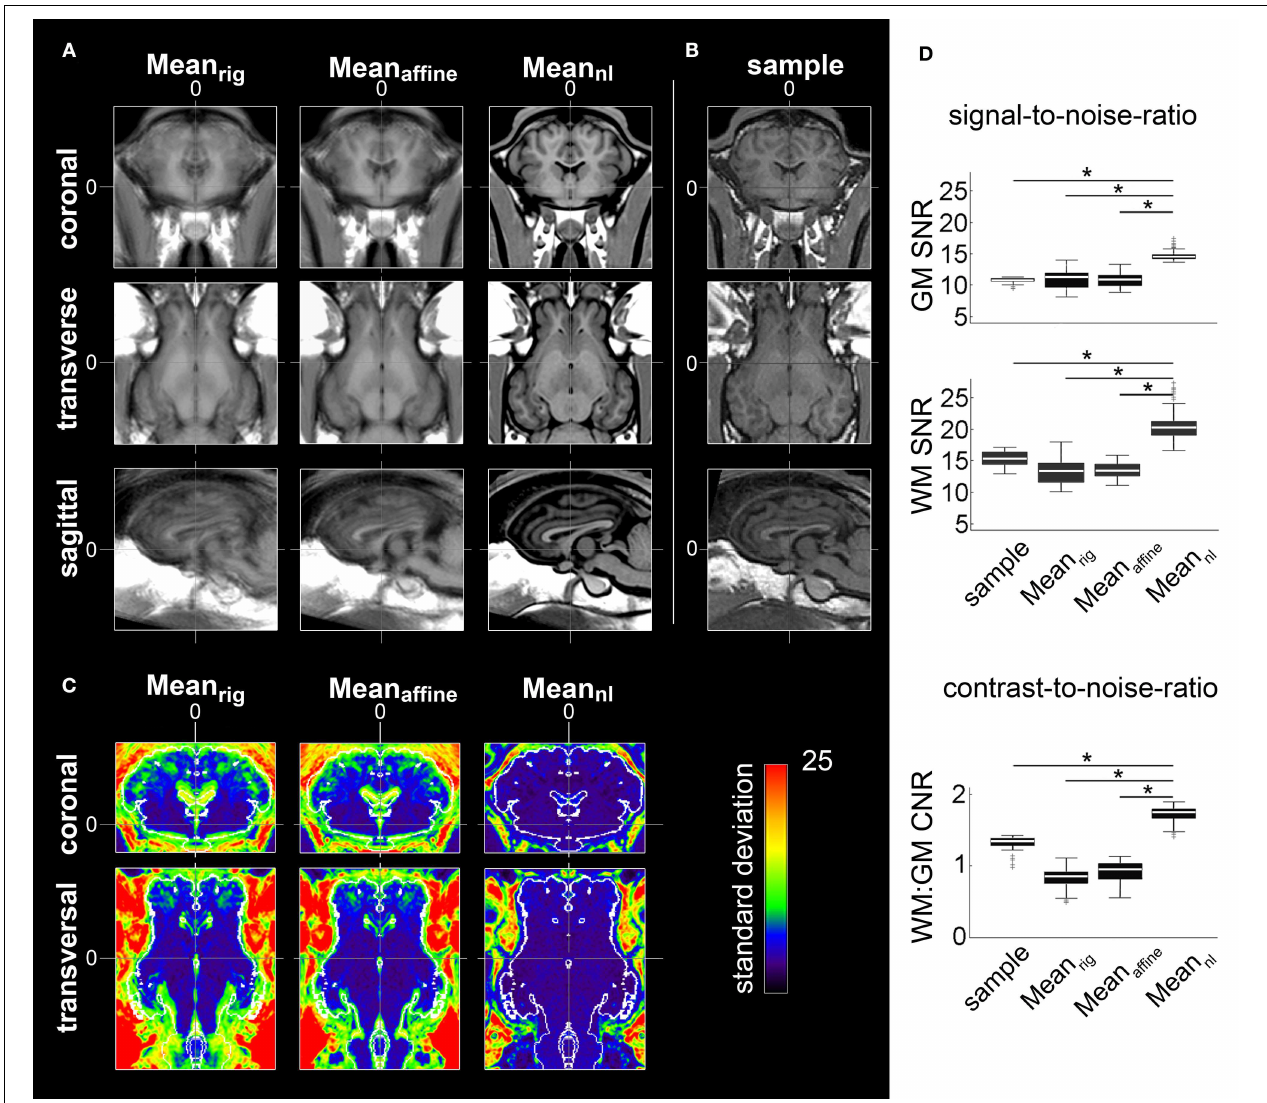
FIGURE 1 | Averages after rigid body (Mean rig ), affine coregistering (Mean affine ), and the final non-linear transformed template (Mean nl ). (A) All images have an isotropic voxel size of 0.25mm and were registered according to ovine stereotactic space for visual comparison of the respective procedure’s results. The high degree of aligment within the Mean nl led to an improved boundary delineation and enhanced detail resolution. (B) Coronal, transverse, and sagittal planes of an individual brain MRI sample for comparison. (C) Coronal and transverse planes showing standard deviation of Mean rig , Mean affine , and Mean nl . The standard deviation inside the cranial cavity decreased after affine and non-linear registration. A restricted RGB lookup table was applied for better visualization of the values for each voxel